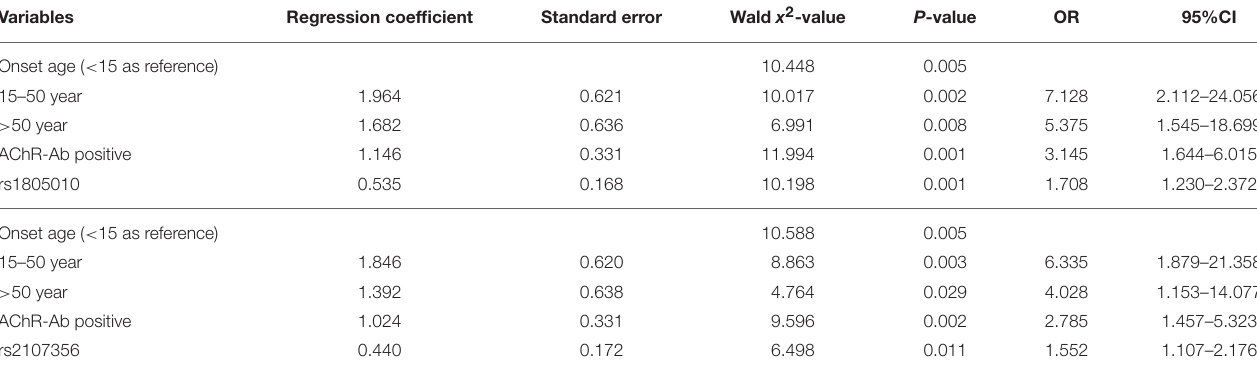
TABLE 4 | Logistic regression analysis in subgroups classified by thymoma. a